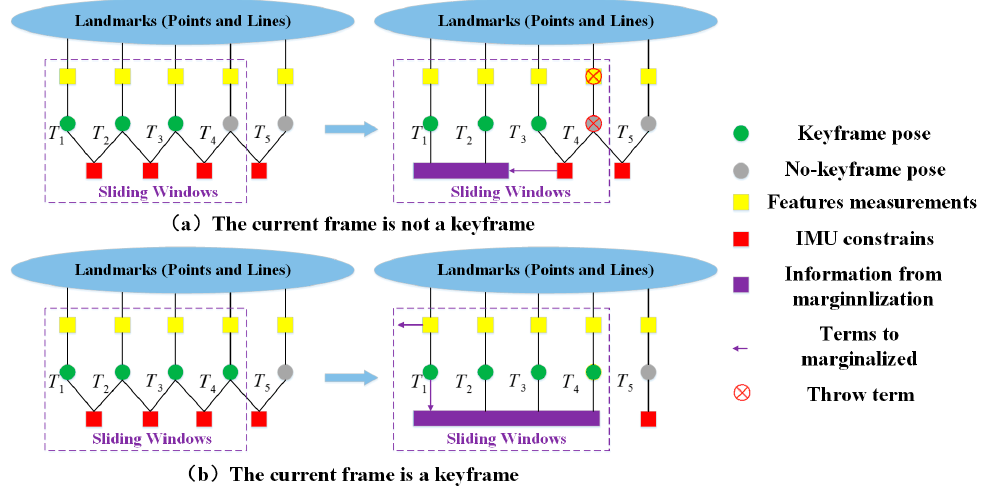
Figure 4. Decision-making pattern of the sliding window model, ( a ) the inserted frame is not a keyframe and ( b ) the inserted frame is a keyframe.